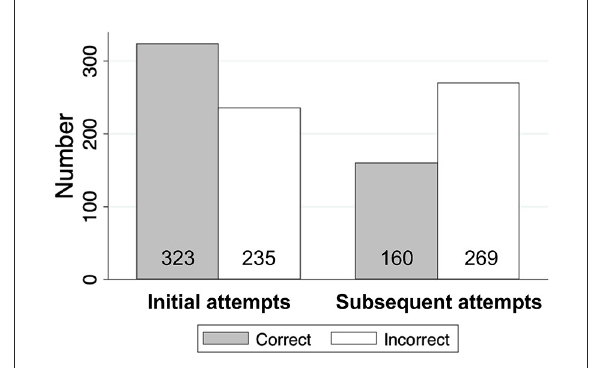
FIGURE2 The number of tokens analyzed in Analysis 2.